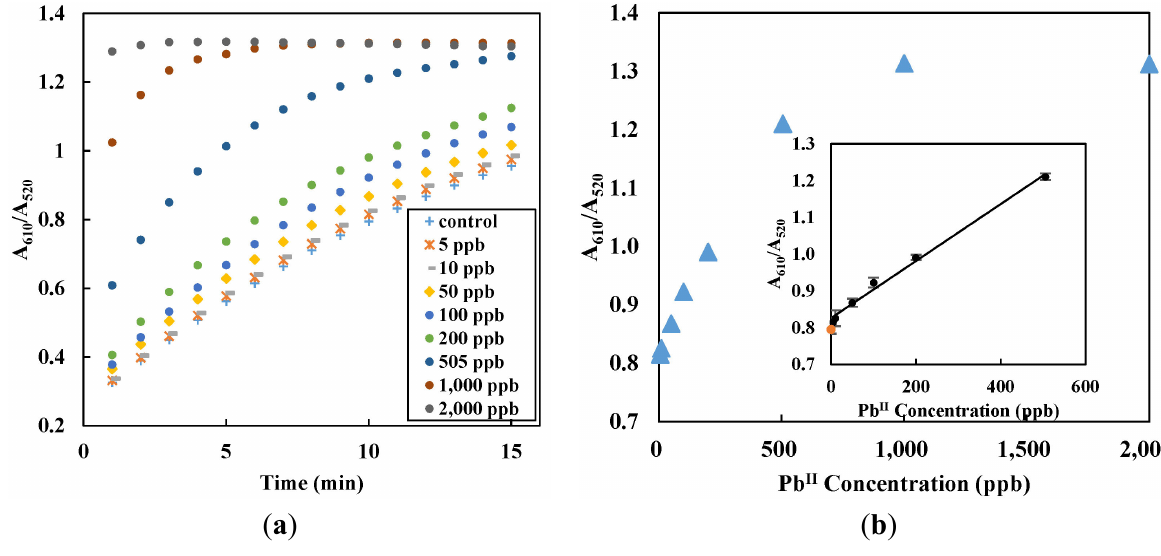
Figure 3. ( a ) Evolution of the absorbance ratio ( A 610 / A 520 ) at 5, 10, 50, 100, 200, 505, 1000, and 2000 ppb of Pb II over time; and ( b ) responses of different concentrations of lead standard solutions. The inserted chart demonstrates the calibration curve for the linear range of 6–500 ppb. All data were collected at 10 min and based on 4 independent measurements. The orange dot in the inserted chart represents the control without the addition of